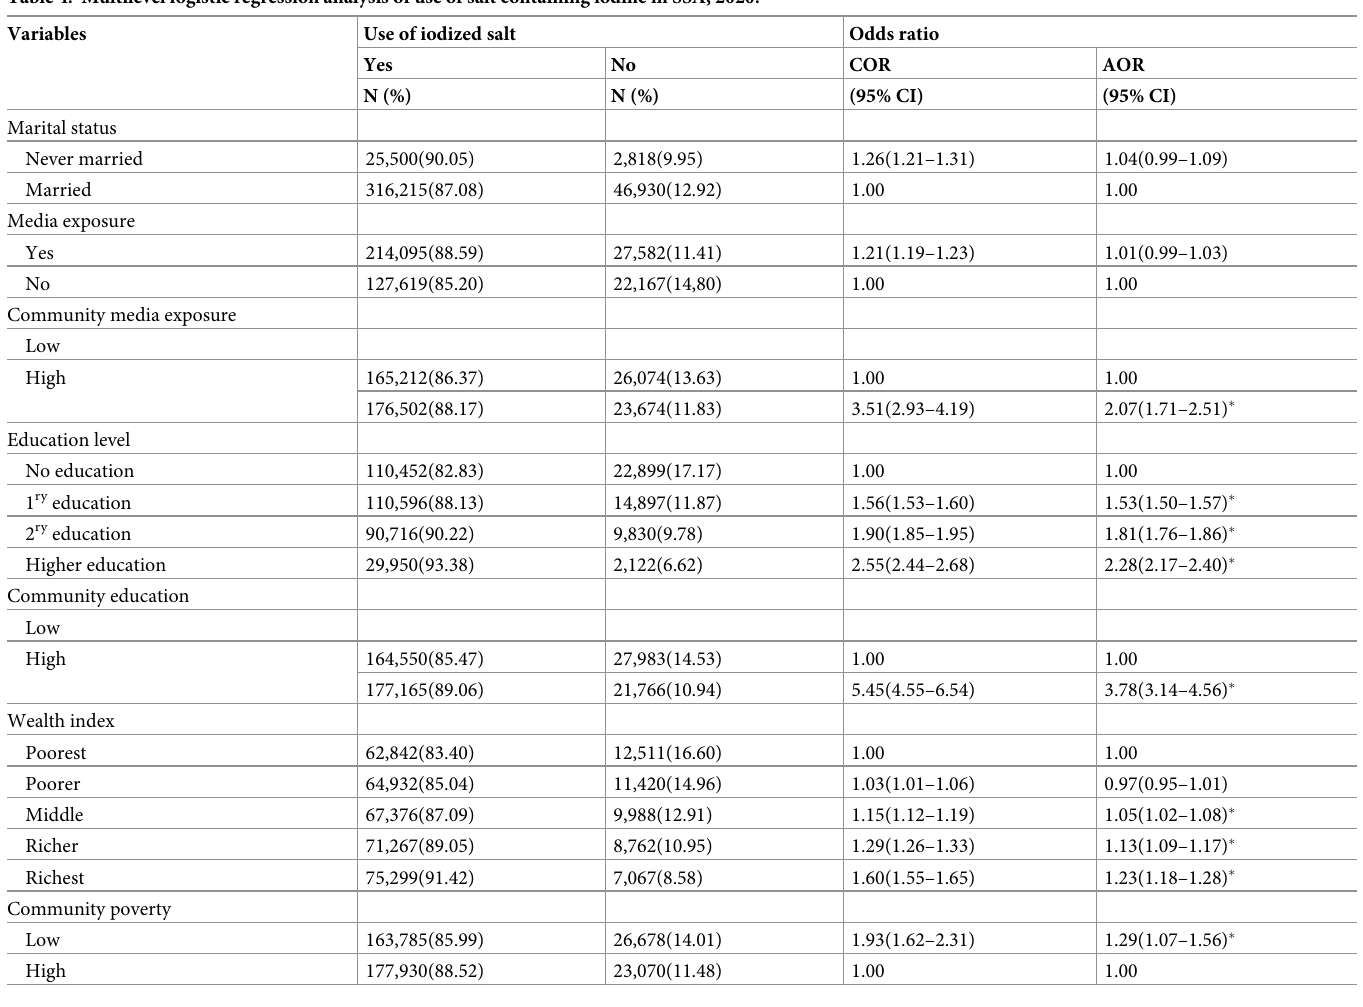
Table 4. Multilevel logistic regression analysis of use of salt containing iodine in SSA, 2020.